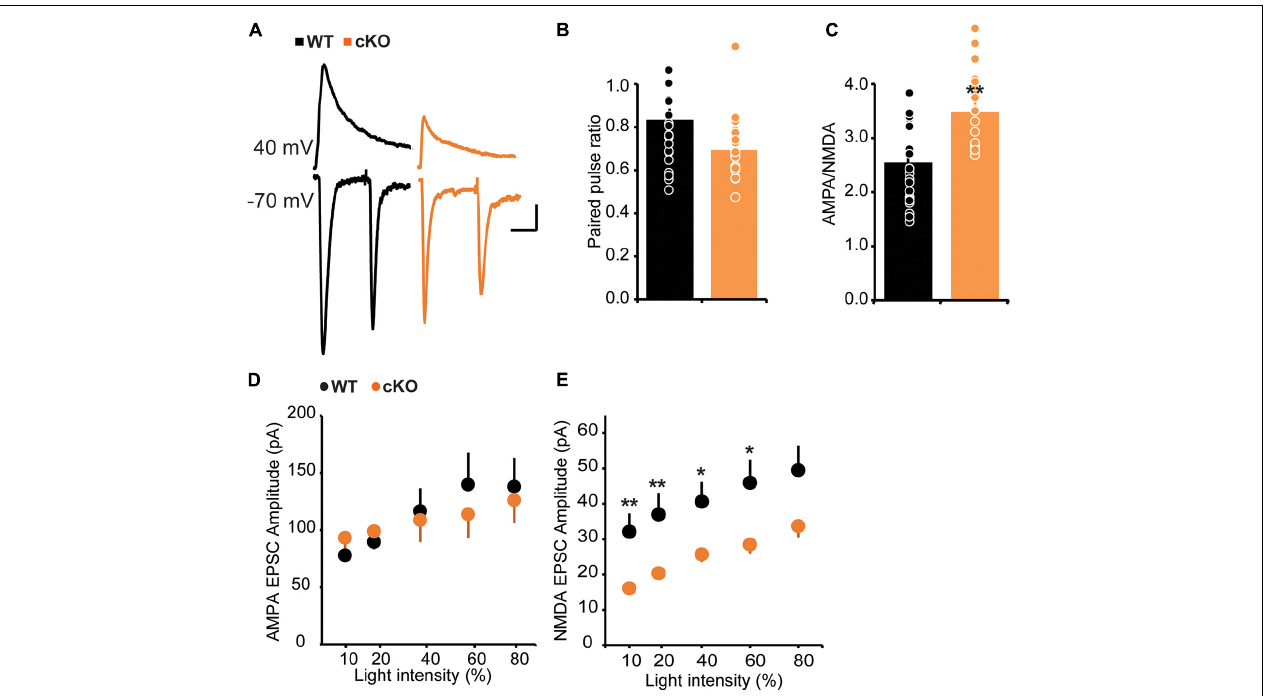
FIGURE 3 | Increased AMPA/NMDA ratio and strength of NMDA receptor mediated synaptic transmission in cKO mice. (A) Sample traces of light evoked AMPA receptor EPSCs at –70 mV, and NMDA current recorded at +40 mV, 40 ms after stimulation onset. (B) No difference in PPR of AMPA receptor mediated EPSC between WT and cKO mice; p > 0.093 ( n = 20 for both groups). (C) Increase in AMPA/NMDA ratio in cKO mice; * p < 0.05. (D) Input-output function of AMPA EPSCs is unaltered in cKO mice compared to WT [WT: n = 14, cKO n = 15; two-way ANOVA, F (1,130), p = 0.9315]. (E) Decreased NMDA EPSC amplitudes